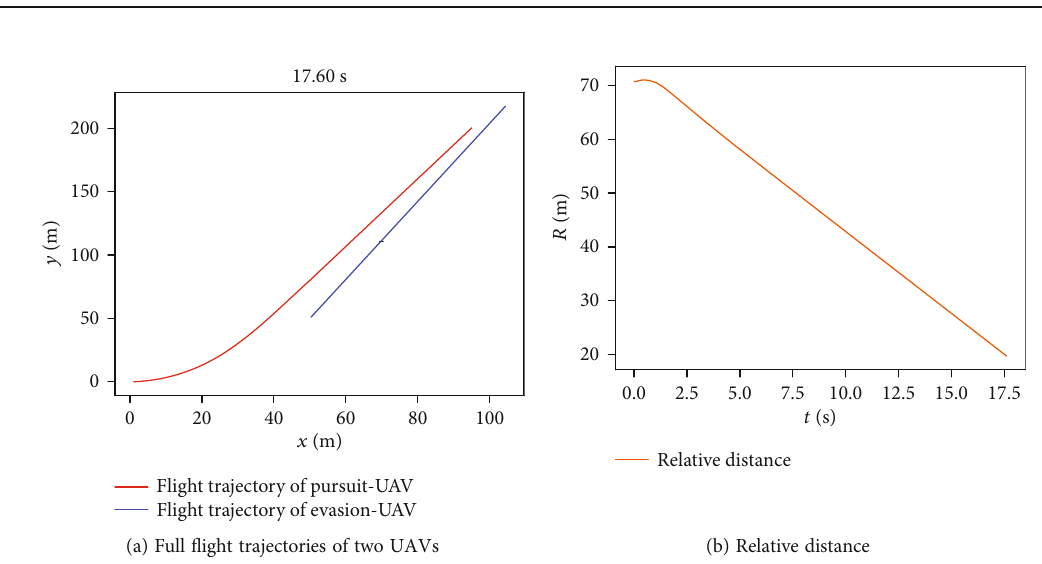
Figure 7: The evasion-UAV with linear